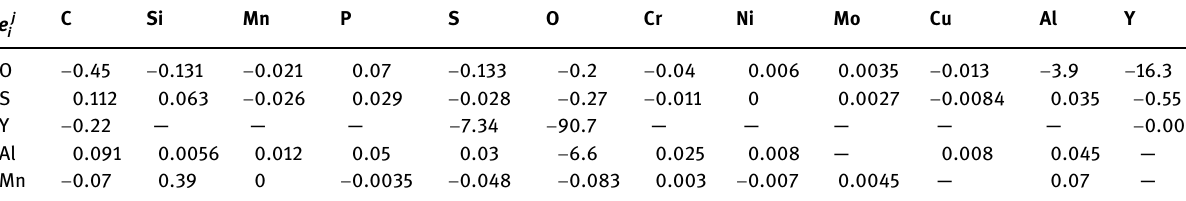
Table 3: First - order interaction coefficients e ij of various elements in liquid steel